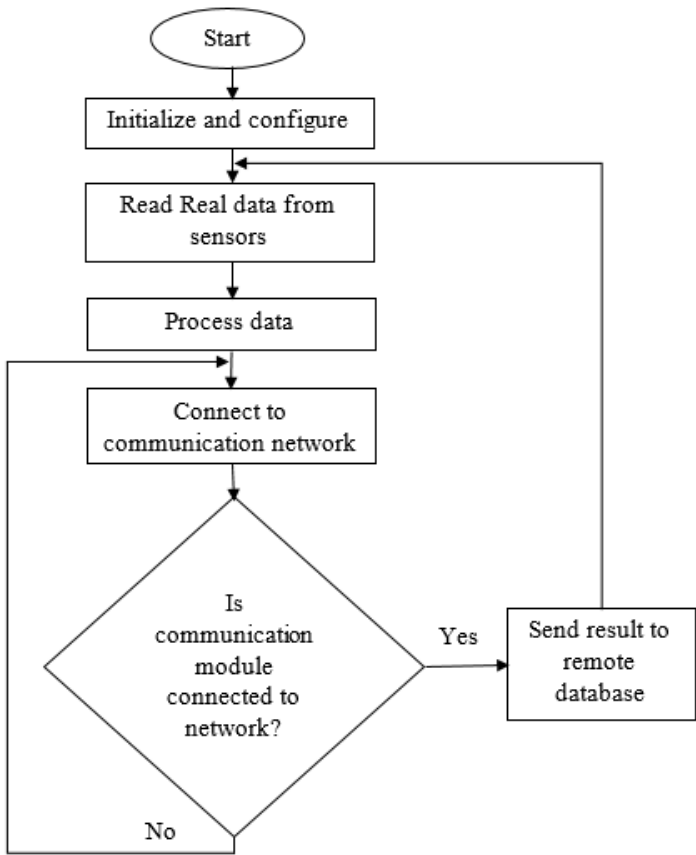
Figure 8. Program running into Arduino Uno.